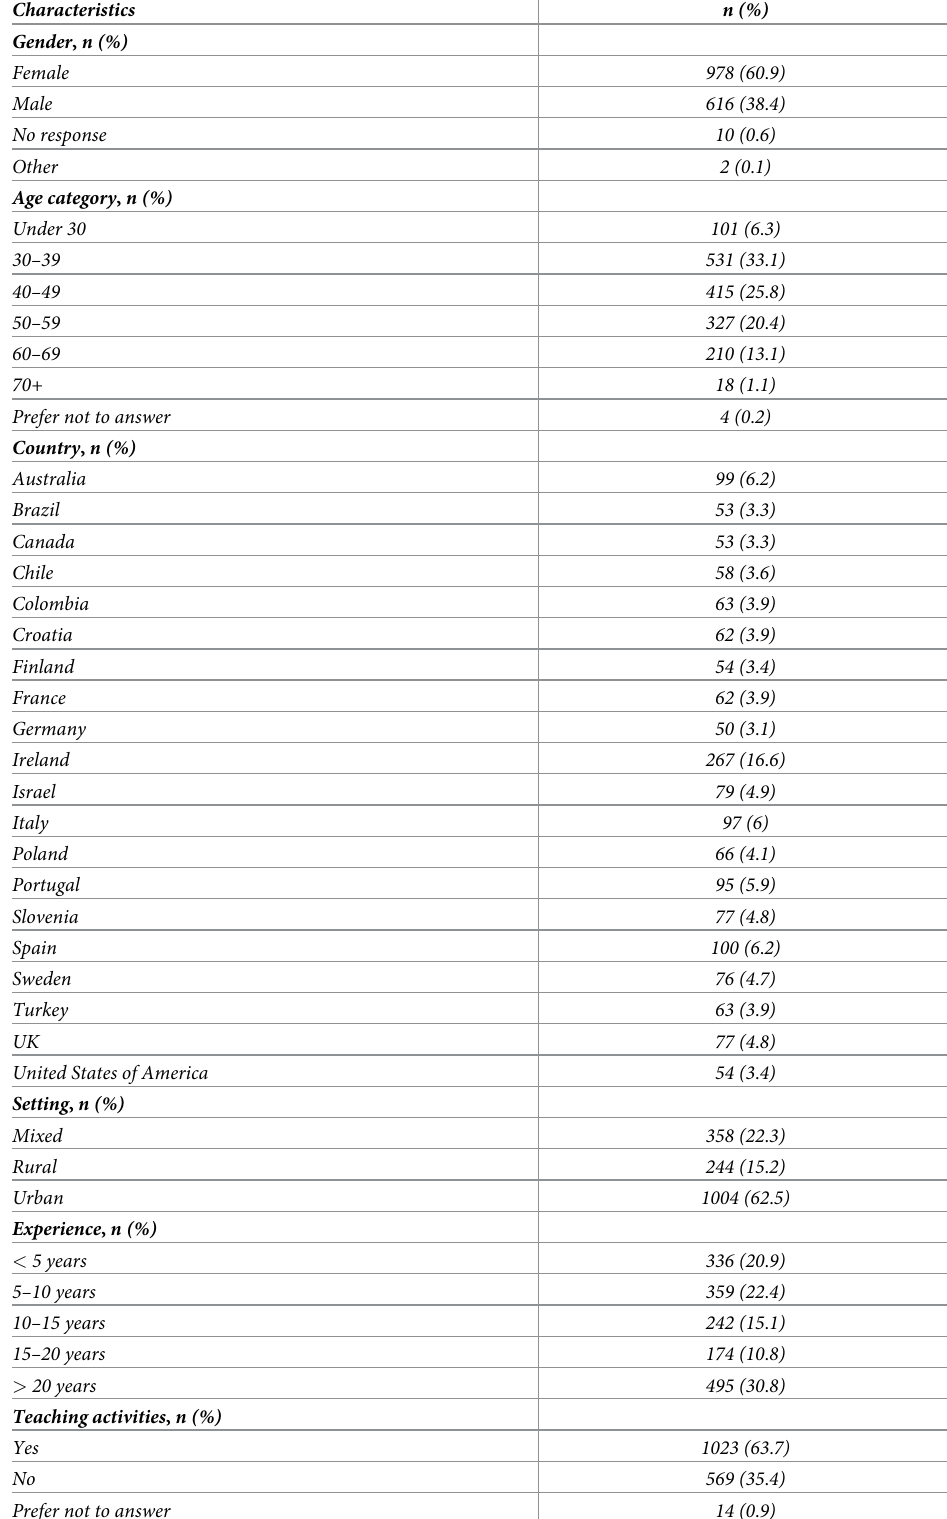
Table 1. Participants’